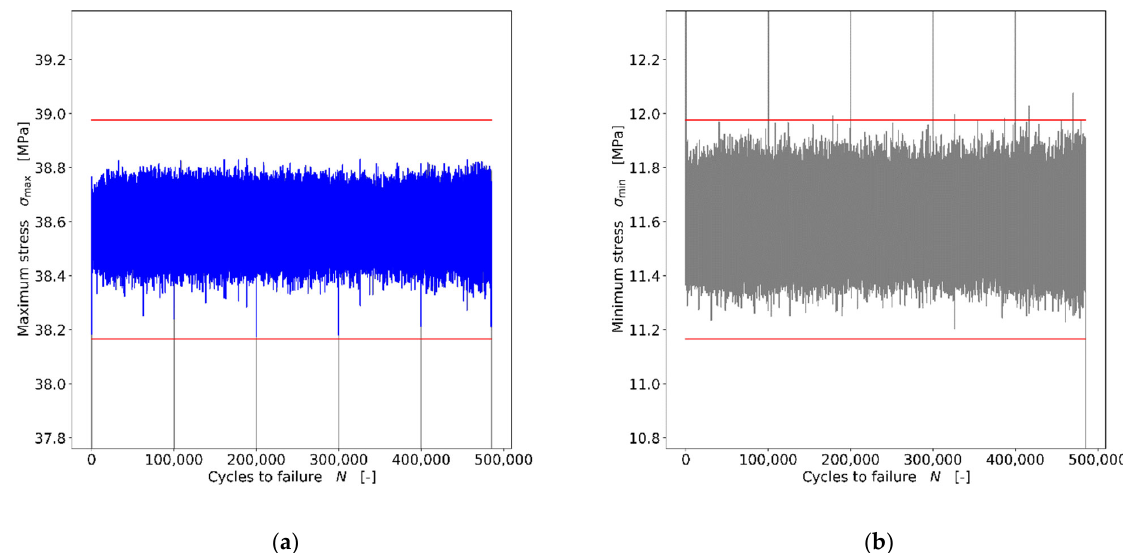
Figure 2. History of maximum stress values ( a ) and minimum stress values ( b ) up to fracture in the ±3% range (red lines) for Al ‐ Pure Sample 71, R = 0.3, σ a = 13.5 MPa, σ max = 38.57 MPa, σ min = 11.6 MPa, N = 485,139.